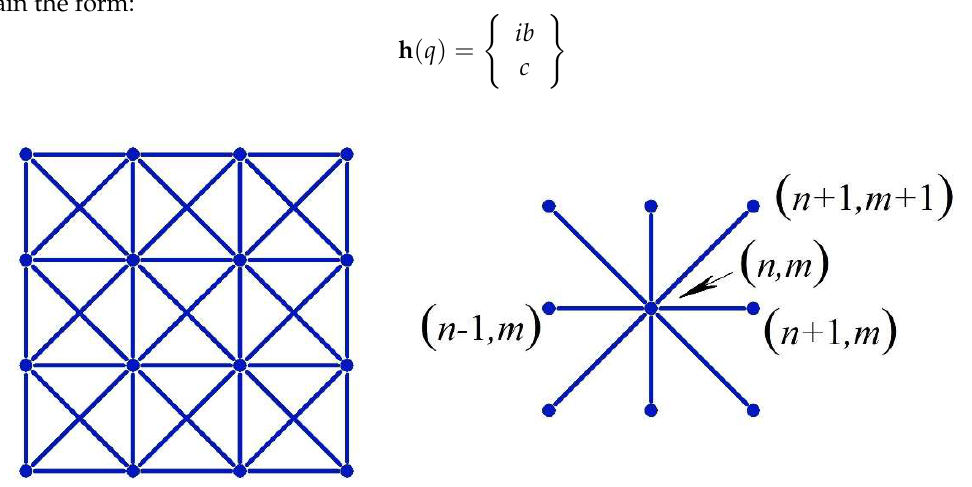
Figure 1. A fragment of the periodic x-braced lattice, and its associated substructure.